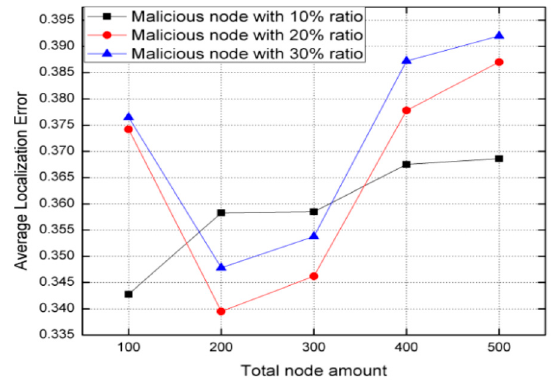
Figure 9. Localization error versus total number by ratio. Table 6. Average localization error under the impact of malicious nodes corresponding to the total node number.